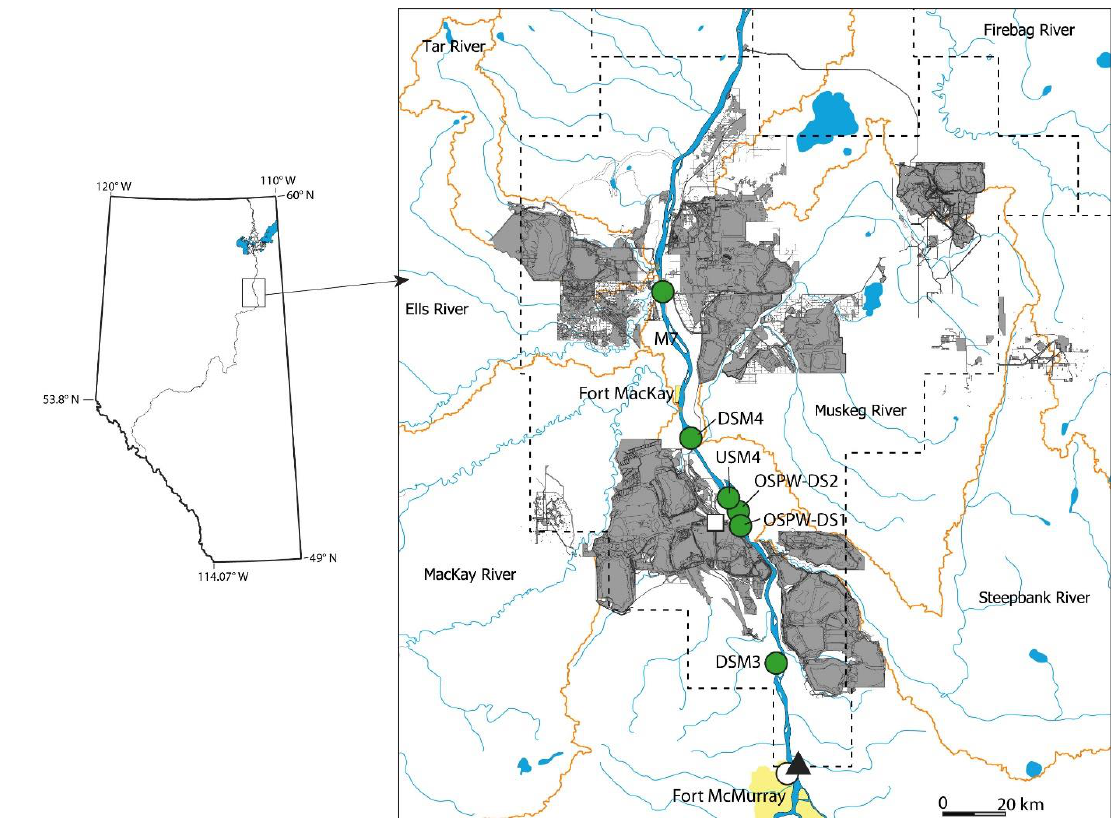
Figure 1. Study locations used in the present work; the extent of oil sands land disturbance (excluding linear features) in 2016 showed in grey; closed circles show fish collection sites; triangle shows gauging stations; open square shows the location of Mildred Lake meteorological station; open circle partially obscured by close triangle shows the location of the FMM WWTP outfall; watershed boundaries for major tributaries also shown (orange lines); dashed lines show the admin- istrative boundary of the mineable oil sands.